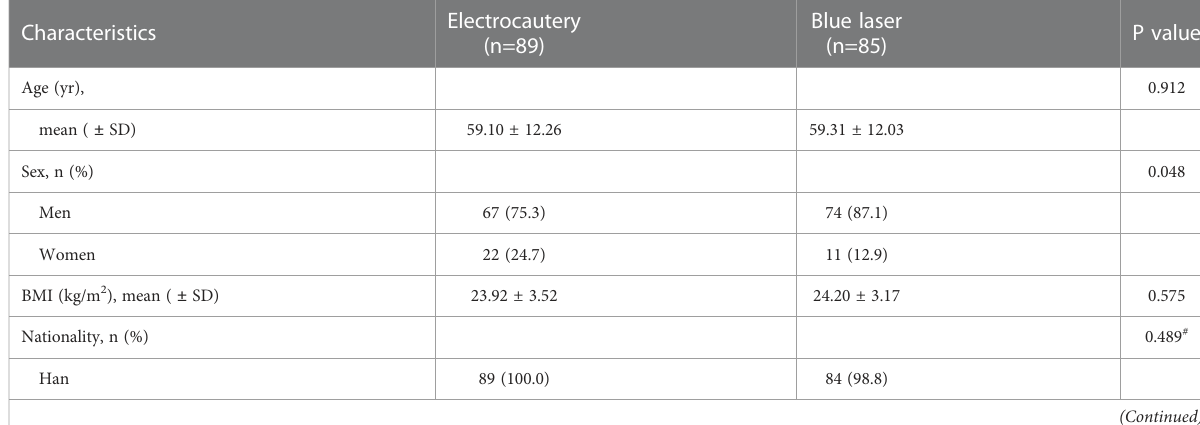
TABLE 1 Baseline characteristics of the 174 patients included in the